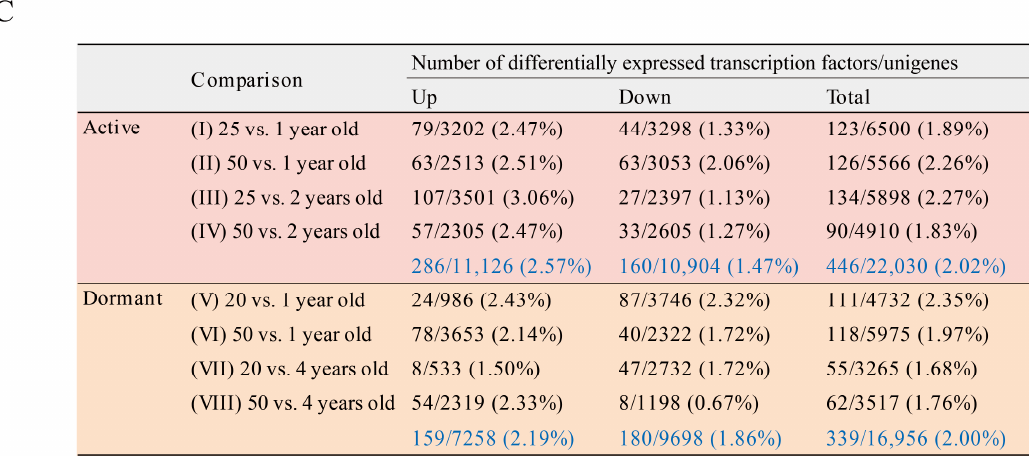
Figure 1. Identification and annotation of 30 differentially expressed transcription factors. ( A ) Ana- lytical flowchart of differentially expressed transcription factors. Branches produced in 2012 were collected from the upper crowns of 1-, 4-, 8-, 12-, 20-, and 50-year-old dormant Larix kaempferi trees on 10 March 2013 for transcriptome sequencing [7]. The uppermost main stems produced in the current year had been collected from 1-, 2-, 5-, 10-, 25-, and 50-year-old active L. kaempferi trees in July 2011 [8] for transcriptome sequencing [9]. After the removal of buds or needles, the left stems from at least three trees from each age category were pooled and used for RNA extraction. A total of 85,446 assembled unigenes generated from our previous study were used to predict the transcription factors [7]. In the active and dormant phases, the transcript levels of transcription factors in the juvenile vegetative (1-, 2-, and 4-year-old) and adult reproductive (20-, 25- and 50-year-old) phases in L . kaempferi were compared. ( B ) Heatmap showing the expression patterns of 30 differentially expressed transcription factors assayed by RNA-Seq. Among the 30 transcription factors, the full-length cDNAs of nine were cloned [2,7,10,11] and the sequences of two were almost the same, so the full-length cDNAs of the left 19 were cloned here (Supplemental Table S1). (* transcript not cloned in this study). ( C ) Statistics of differentially expressed transcription factors and